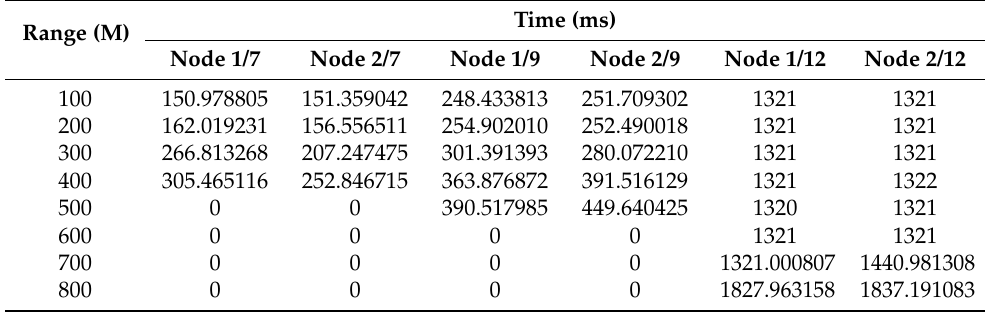
0 Figure 11. The delay graph from the reassessment of several spreading factors.